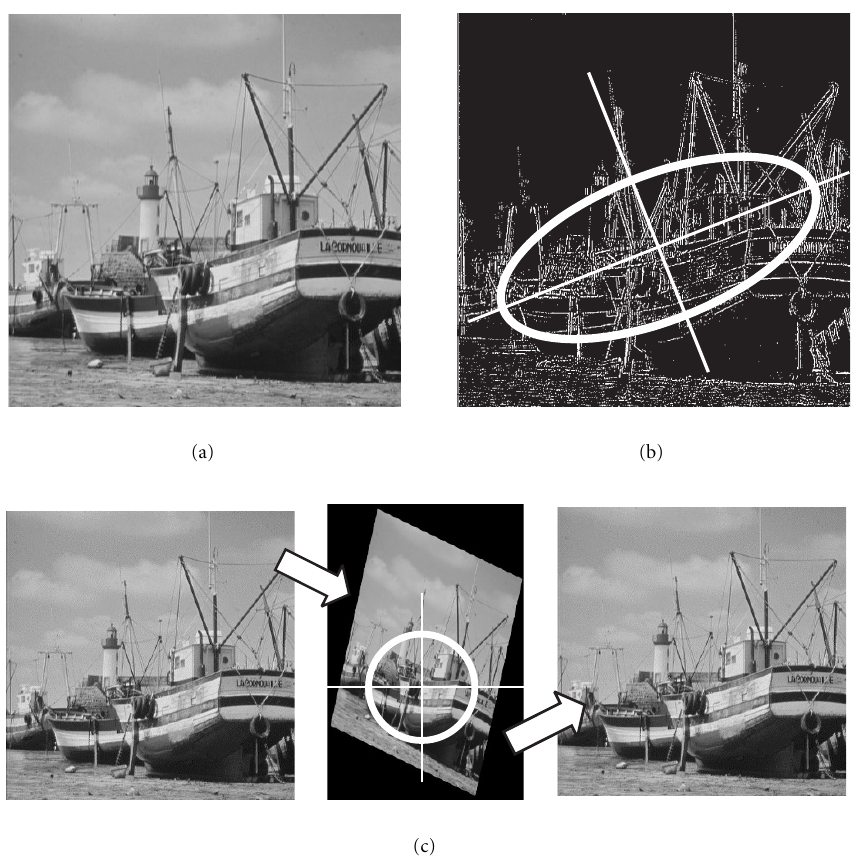
Figure 3: Example of feature-based geometric normalization. Image edges are first extracted (b). Then the image is rotated and scaled in such a way that the inertial axis of image edges assume a reference orientation and scale (c). After watermark insertion the image is brought back to its original